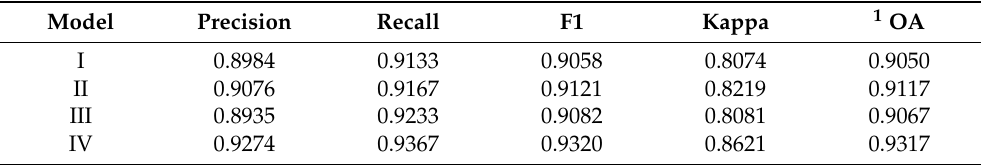
Table 3. Comparison of the accuracies of the models with different module combinations in test area